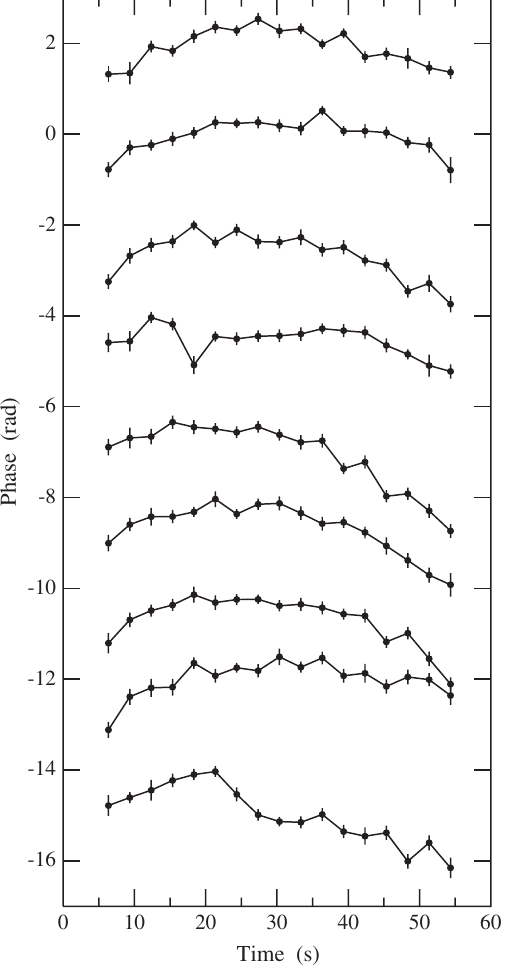
FIG. 7. Measurements of the phase φ in Eq. (3) as a function of the time during a machine cycle in seconds. The size of the machine cycle time bins is 3 s. The spin tune was fixed at a single value for this analysis. The vertical units are radians. The nine different curves show the behavior for subsequent machine cycles during a typical run. In each successive case, 2 rad has been subtracted from the phase values to separate the curves. Each curve begins near 1 rad and then follows its own history.